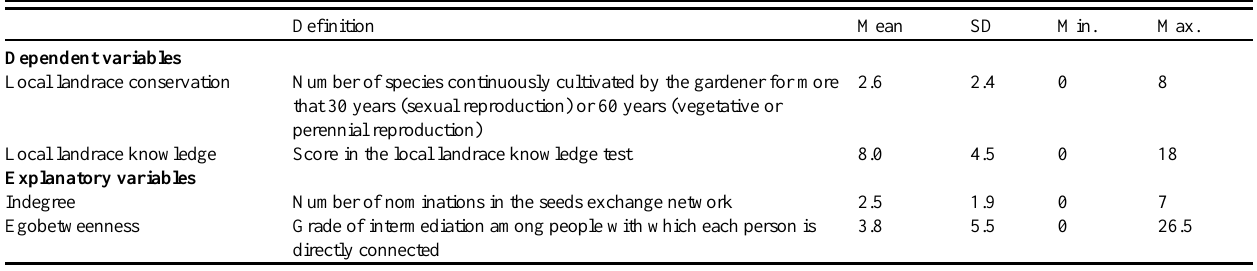
Table 2 . Definition and descriptive statistics of the variables used ( n = 55).